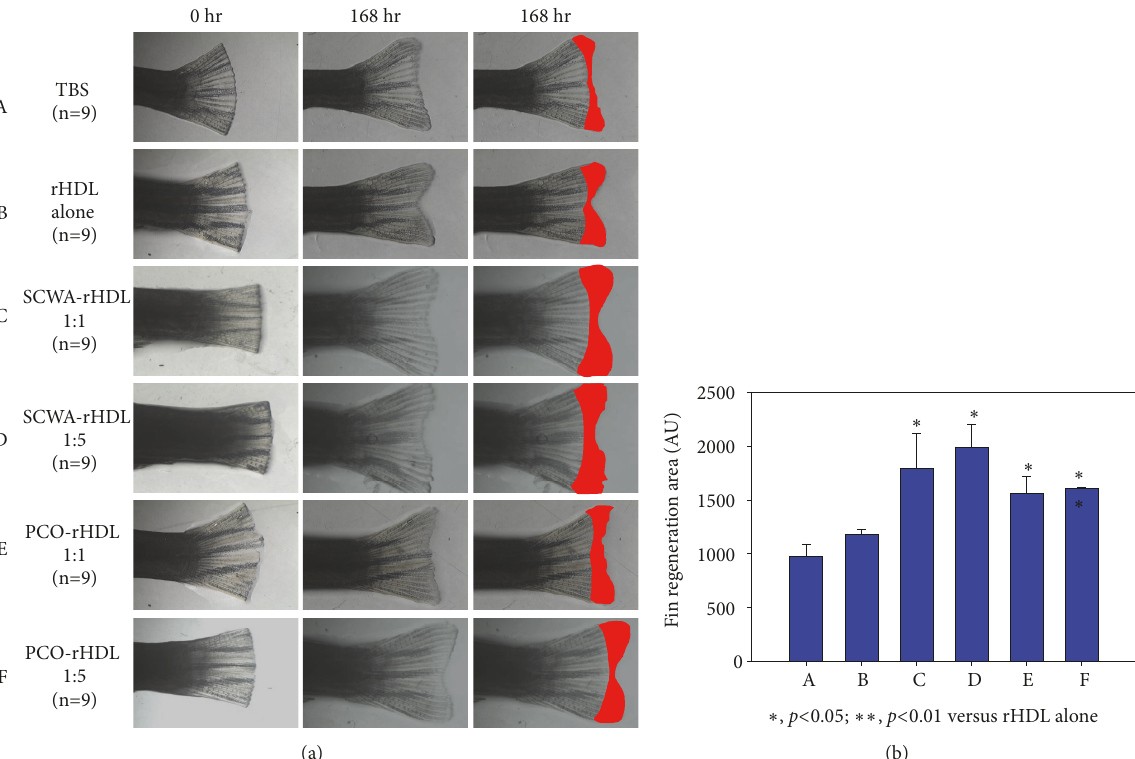
Figure 7: Wound healing activity of PCO-rHDL and SCWA-rHDL. Improvement of zebrafish fin regeneration by injection of reconstituted high-density lipoprotein(rHDL) containing eitherpolicosanol or SCWA. (a)Photo of tail fin regenerationupon injection of rHDL containing policosanol or SCWA with administration of normal diet. (b) Quantification of fin regeneration area at 168 h after the rHDL injection. Data shown are the mean ± SD of three independent experiments (n=9). ∗ , p < 0.05; ∗∗ , p <